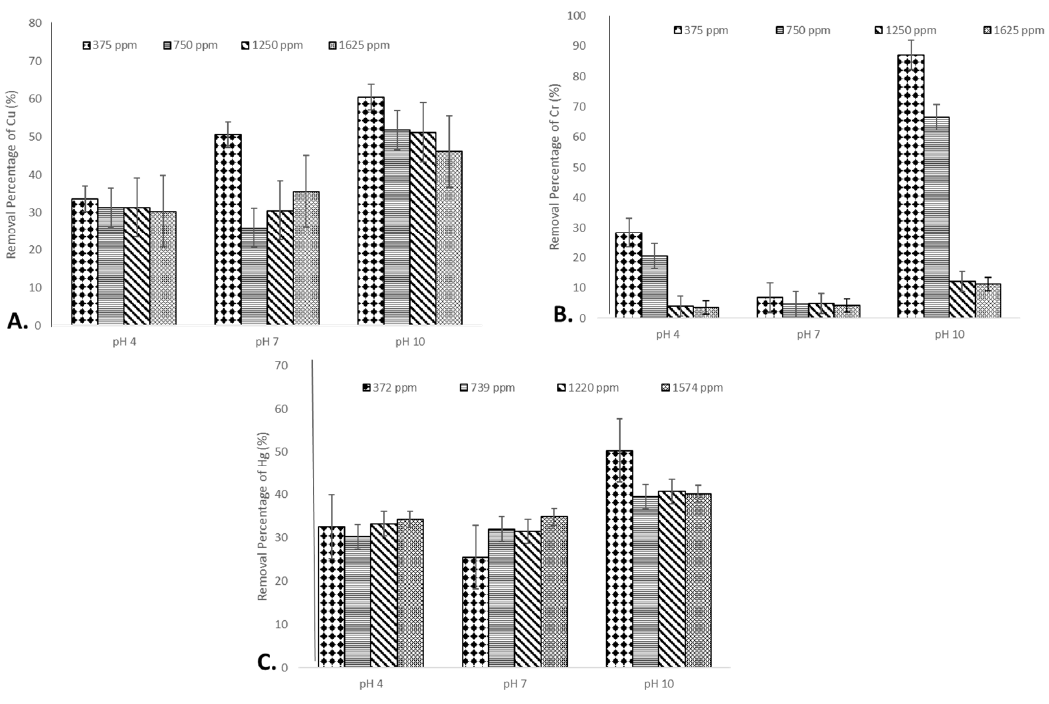
Figure 4. Removal percentage of copper ( A ), chrome ( B ) and mercury ( C ) after the coagulation–floculation process with MAT.